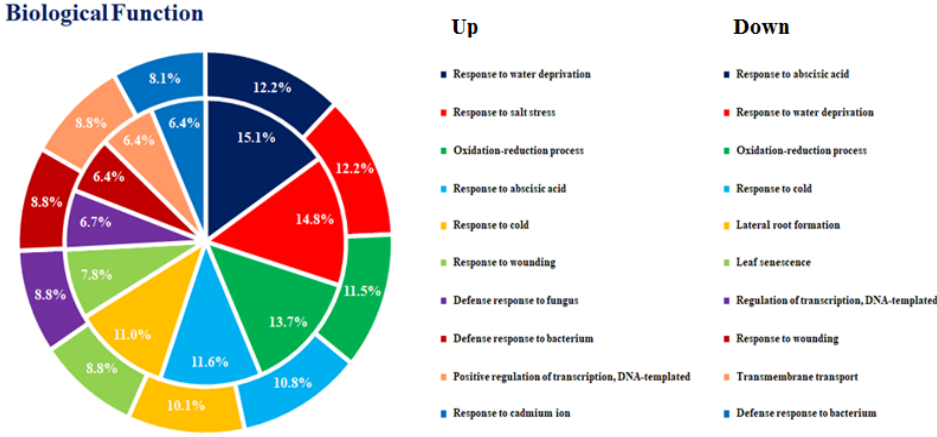
Figure 2. Summary of upregulated (outside) and downregulated (inner side) genes that involved in